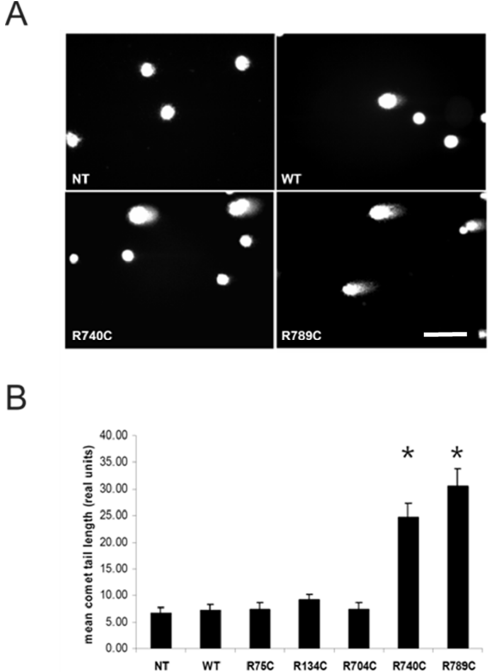
Figure 7. Single cell gel electrophoresis (comet assay) of HT1080 cells transfected with collagen II variants. ( A ) Nuclei of non-transfected (NT) and WT collagen-expressing cells were round when visualized after electrophoresis. In contrast, a comet-shaped appearance of fragmented nuclei was seen in cells transfected with R740C and R789C, indicating ongoing DNA fragmentation. Scale bar, 25 µm. ( B ) The mean tail length was evaluated for these comets (20 cells for each genotype) using the CometScore software. A significant increase in tail length was observed in cells transfected with R740C and R789C collagen constructs, while cells transfected with all other constructs behaved similar to non-transfected controls. Asterisks indicate significant difference compared to and WT collagen-expressing cells with p < 0.05.